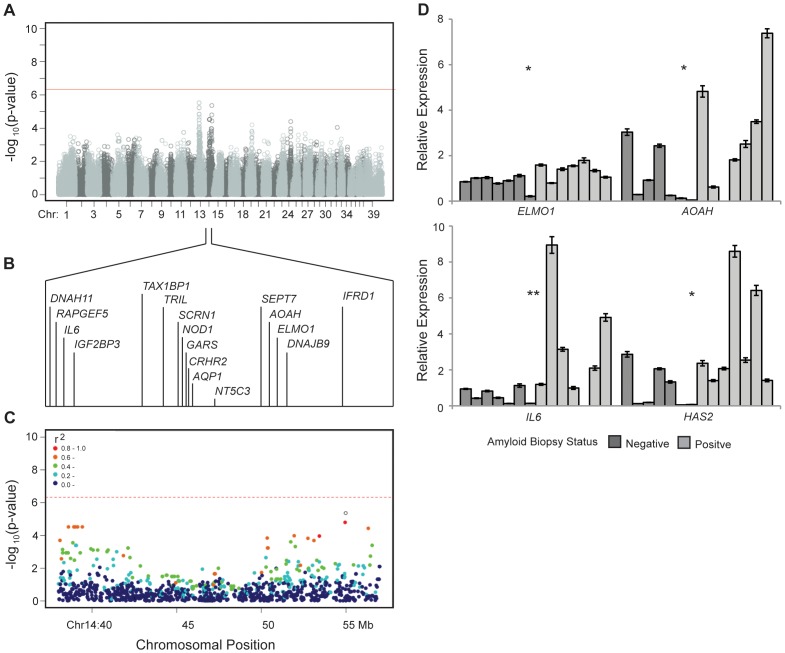
A novel locus on chromosome 14 is associated with Shar-Pei amyloidosis. A. The genome wide association study of amyloidosis positive (n = 37) and negative (n = 14) individuals revealed a signal of association on chromosome 14 (14∶54948811, pMM = 4.34×10−6) which was of slightly reduced strength to that observed on chromosome 13 (13∶27371905, pMM = 3.0×10−6). B. A zoomed view of a subset of the genes across the chromosome 14 disease associated region, C. This region encompasses two peaks in moderate LD (r2 = 0.6) as indicated by heat colouring. A genome wide significant threshold (red dotted line) has been defined using as Bonferroni 5%. D. The scaled plots of genes demonstrating differential expression between amyloidosis negative (n = 7) and positive (n = 7) kidney biopsies. Samples are shown in the same order for each gene and also in order of phased H14 haplotypes (Table S3). Each sample registered expression, although in some cases it was negligible. p-values 0.05>0.01, *>**.